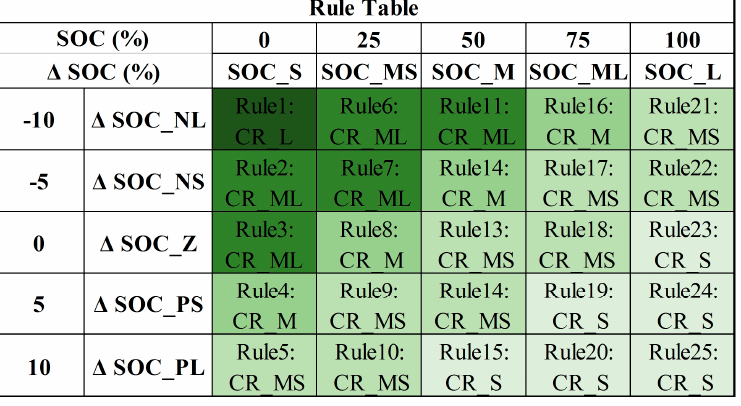
Figure 5. Rule table of the proposed fuzzy logic control (FLC) controller.